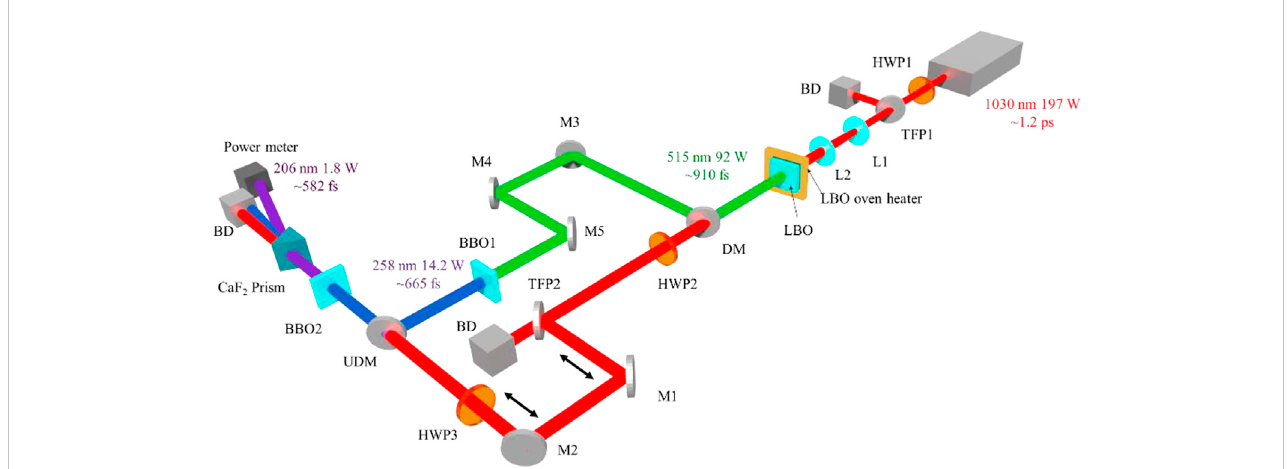
FIGURE 1 Schematic representation of the high-power, sub-ps, all-solid-state DUV laser. HWP, half waveplate; TFP, thin- fi lm polarizer; BD, beam damper; L1 – L2, lens; DM, dichroic mirror at 515 nm and 1,030 nm, UDM: UV dichroic mirror at 258 nm and 1,030 nm; M1 – M2, 1-µm mirrors; M3 – M5, 515-nm mirrors; HWP1 – HWP3: half waveplate at 1,030 nm. LBO: lithium triborate; BBO1 – BBO2: β -BaB 2 O 4